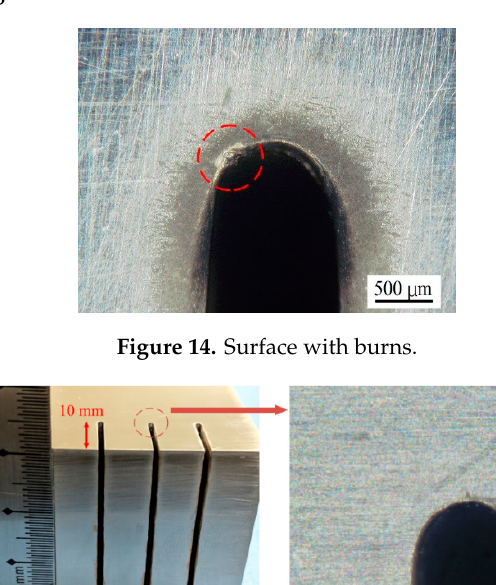
Figure 13. Different current status with different electrodes.